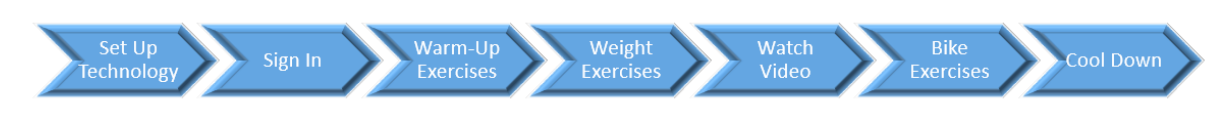
Figure 2. Telehealth-delivered pulmonary rehabilitation (telePR) session